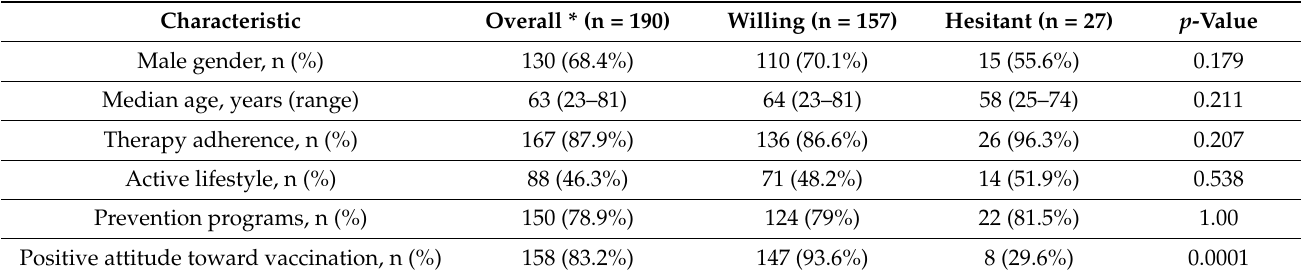
Table 2. Sociodemographic, lifestyle, and clinical characteristics of patients willing or hesitant to receive the COVID- 19